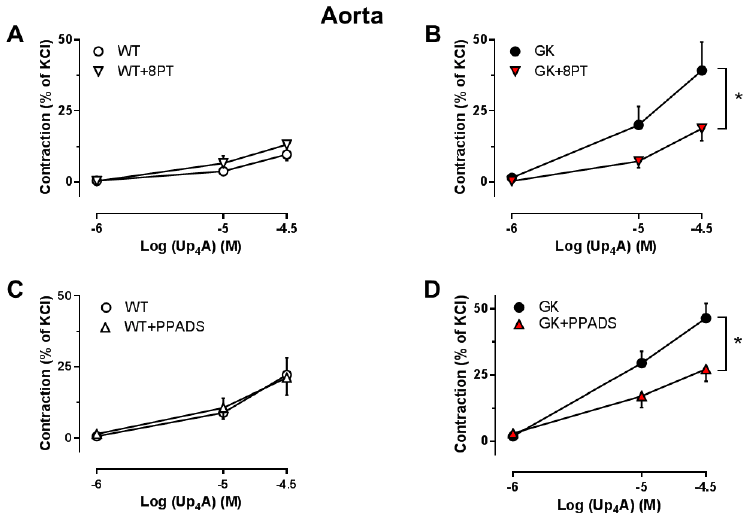
Figure 6. Effects of the P1R and P2R antagonists on vasoconstrictor response to Up 4 A in aortas from WT and GK rats. Concentration response curves for Up 4 A in aortas in the absence and presence of the non-selective P1R antagonist (8PT, 10 − 5 M) ( A , WT n = 3; B , GK n = 8) and the non-selective P2R antagonist (PPADS, 10 − 5 M) ( C , WT n = 4; D , GK n = 6). Data are presented as mean ± SEM as percentage contraction of KCl. * p < 0.05, calculated with two-way